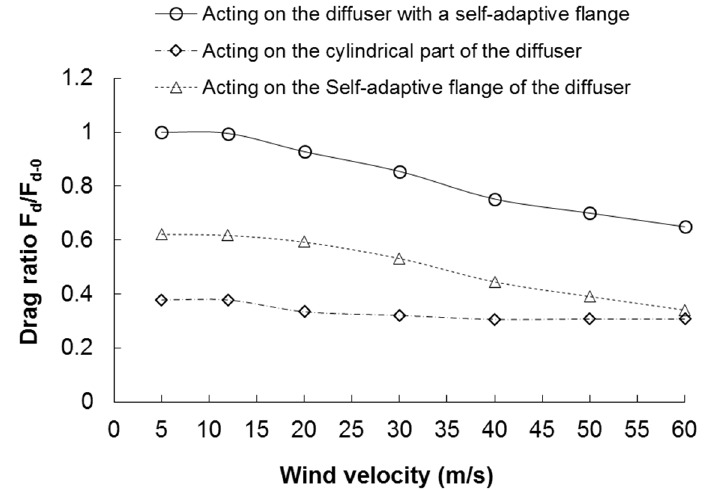
Figure 19. Drag ratio of the diffuser with a self-adaptive flange at various wind